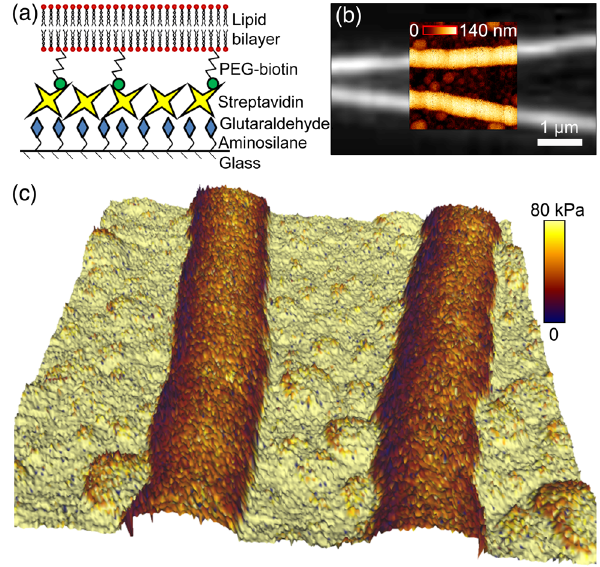
FIG. 1. Nanomechanical mapping of membrane nanotubes. (a) Schematic illustrating the specific attachment of the nanotube lipids to the functionalized glass surface (not to scale). (b) AFM topography image (yellow and brown) of two nanotubes super- imposed on the fluorescence image (gray) displaying the same nanotubes. AFM height scale (0 – 140 nm) displays high and low regions as bright and dark, respectively. (c) AFM mapping of the rigidity (colors) superimposed on the 3D topographic represen- tation of the nanotube heights. Colors show stiff and soft materials as bright and dark, respectively. Both nanotubes have a rigidity of 38 (cid:2) 14